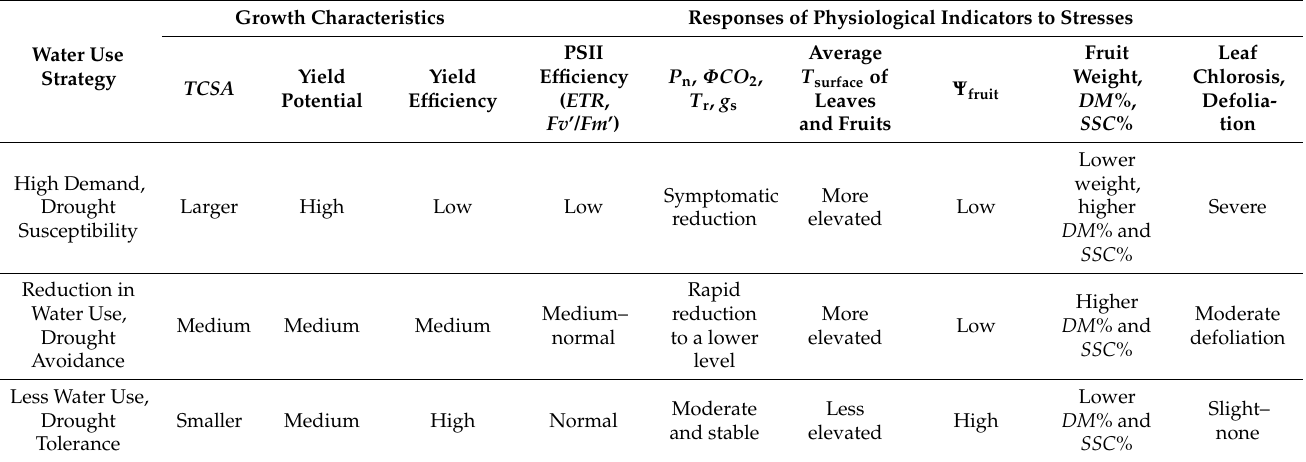
Table 3. Growth characteristics and stress indicators of Ambrosia TM scion–rootstock systems with different vigor and water use